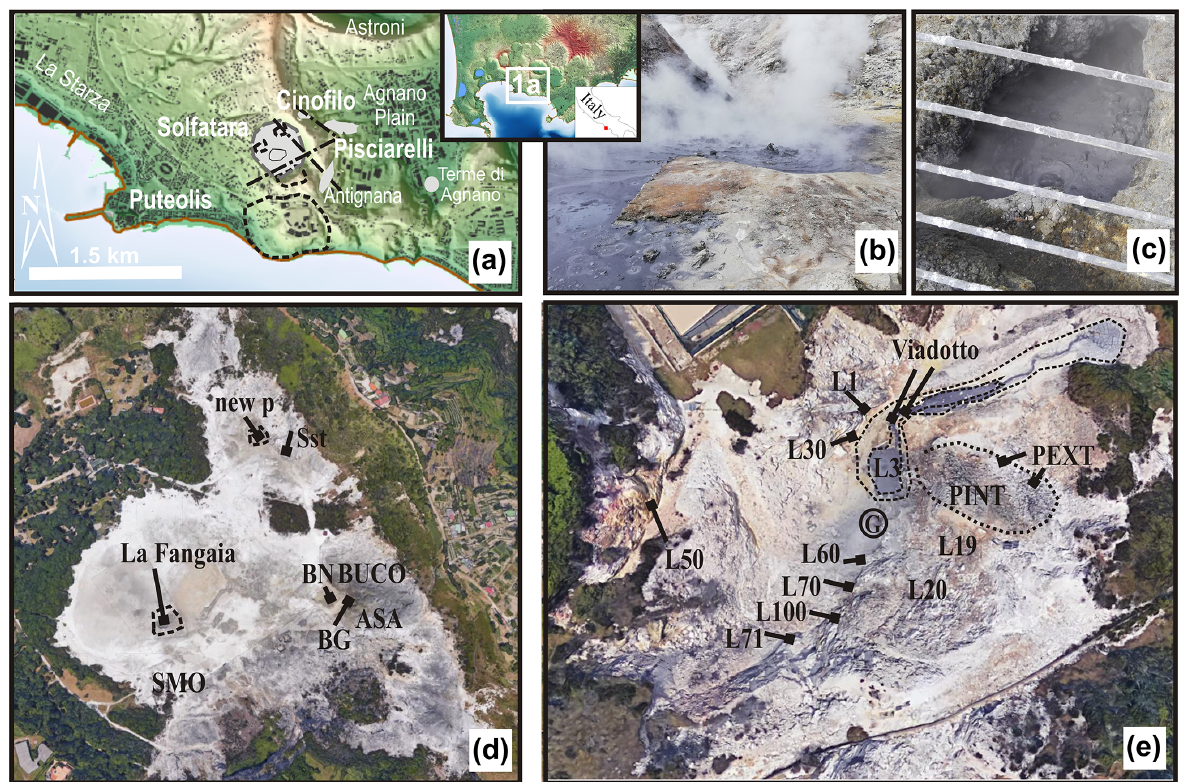
Figure 1. (a) The investigated acid sulfate areas (gray shaded) of Puteoli within the Campi Flegrei caldera (Italy): the Solfatara crater, Pisciarelli, Cinofilo, Antignana, Terme di Agnano. The map shows relevant structures: lava domes (dashed lines), fault systems (point–dash lines), La Starza marine terrace, the Astroni explosive crater and the Agnano Plain. (b) Pisciarelli pool on June 2018; (c) new pool (hereafter New P) at Solfatara on September 2017. (d) the Solfatara crater with sampling sites, notably the Bocca Grande fumarole (hereafter BG) and La Fangaia mud pool and the old thermal baths (hereafter Sst) as well. (e) The Pisciarelli sampling sites, notably geyser vent and mud pool (hereafter G and L3, respectively), the latter delineated by shaded lines defining the observed widening variations. Map in (a) modified by De Natale et al. (2016); Google Earth© views in (d) and (e)